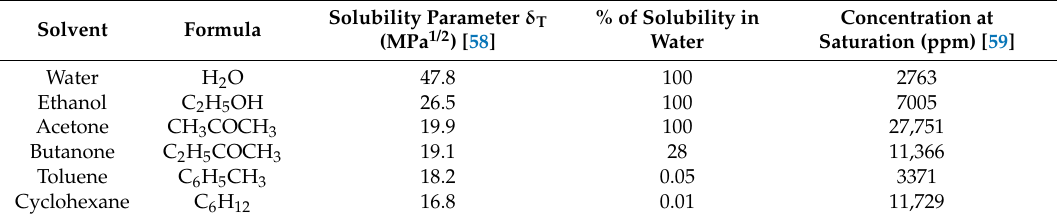
Table 2. Properties of volatile organic compounds (VOC) and concentration (ppm) of solvents at saturation in a vapor stream at room temperature according to Antoine’s equation.